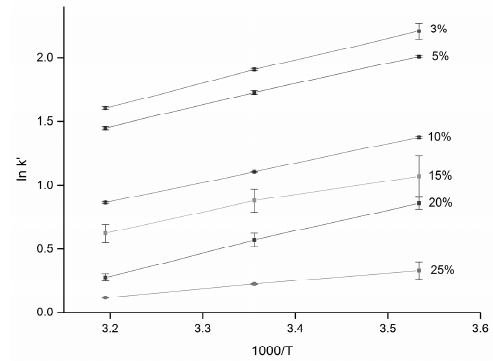
Figure 3. Thermodynamics of the separation—van’t Hoff plots. Retention factors were calculated for the second peak of glucose ( β -anomer). Experimental conditions were as follows: flow rate 2 mL/min, injection volume 10 µL. The concentration range was 1–5 mg/L, at least three replicates at each of five concentration levels, all plots are linear within the measurement precision (error bars show the standard deviation of at least three replicates).